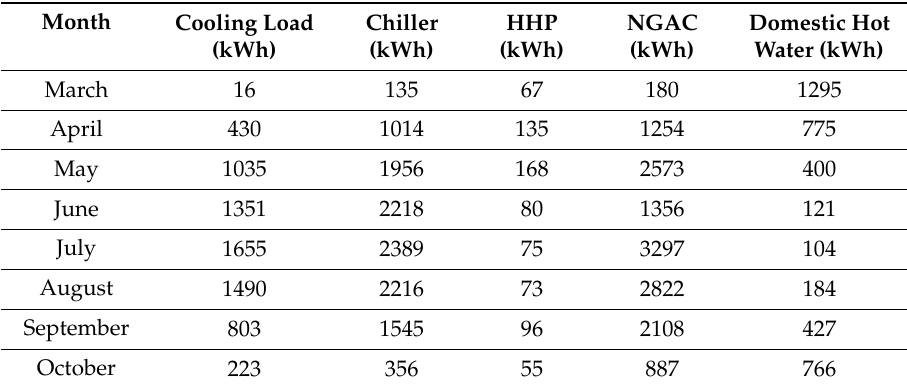
Table 10. Produced energy in cooling mode.